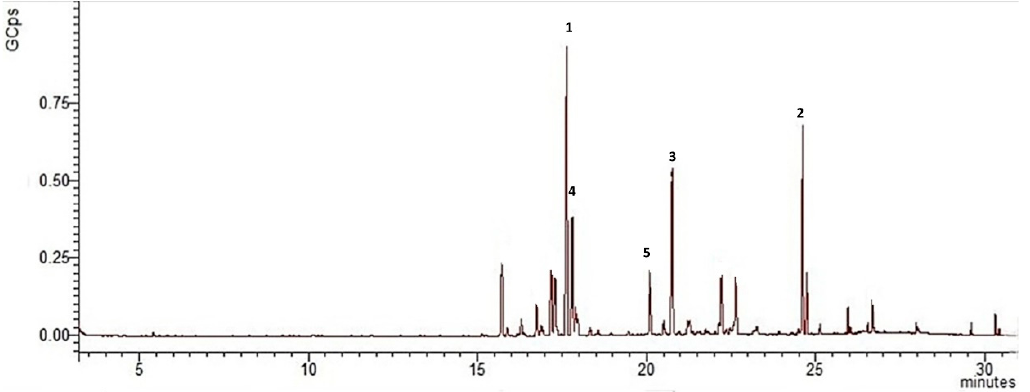
Figure 3. Chromatogram of R. carthamoides EO from the wild population, compounds derived from GC-MS analysis, where GCps—Giga Counts per second and the numbers refer to the following: 1—ledene oxide, 2—cyperene, 3—D-carvone, 4—estragole, and 5— β -selinene.